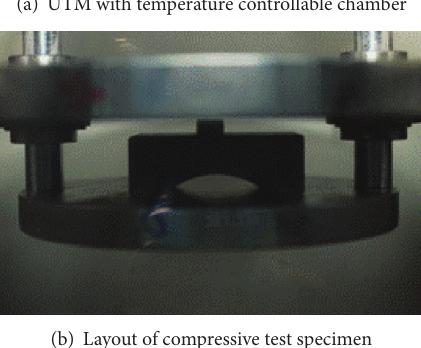
Figure 4: Compressive strength test of NGH pellet specimen in UTM.